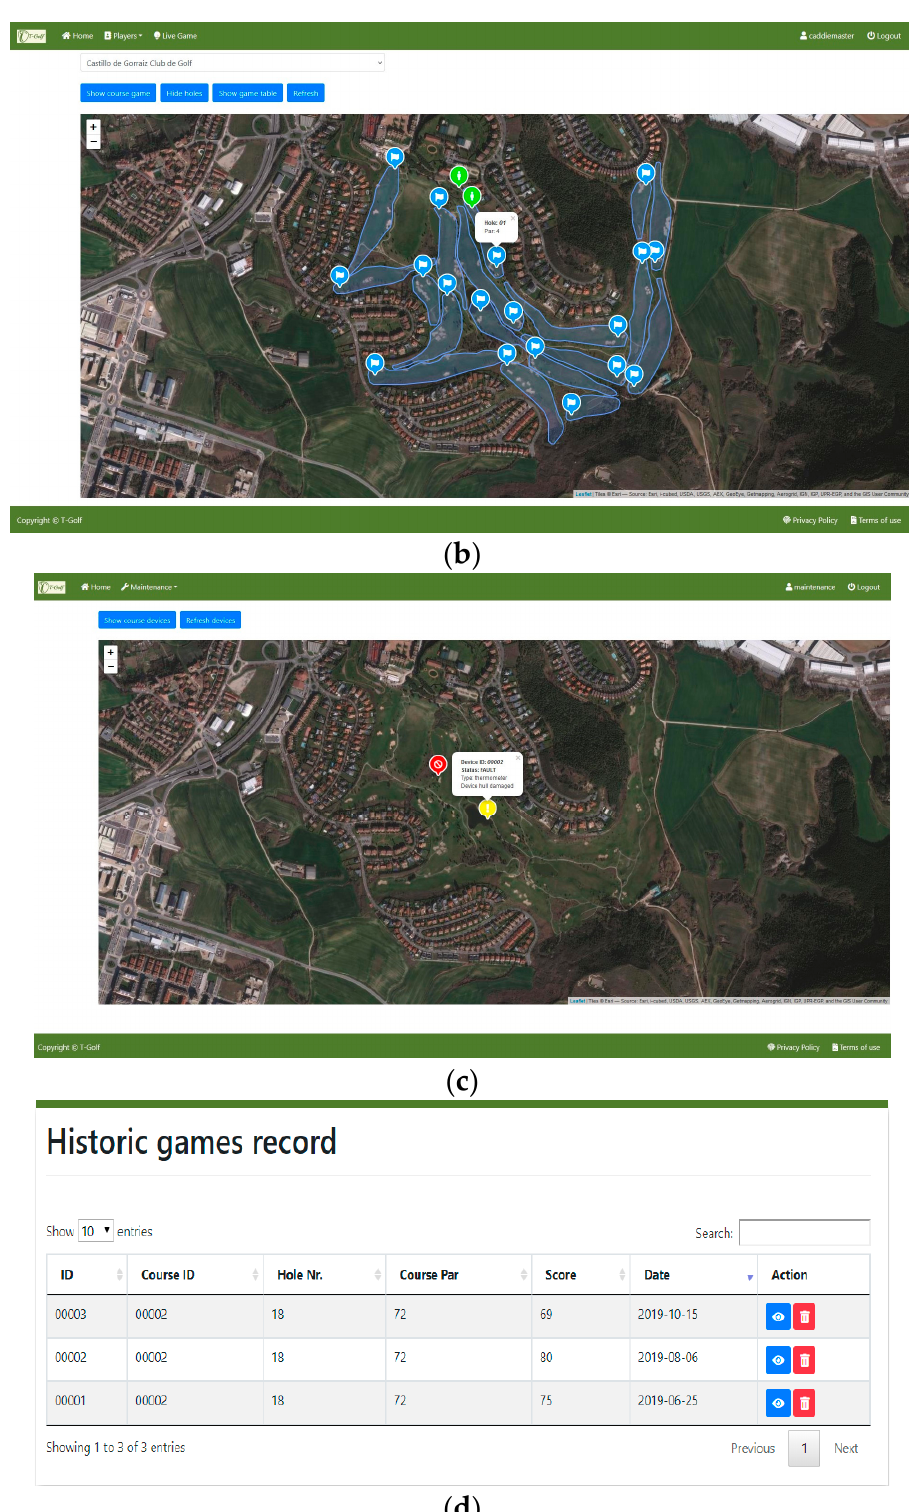
Figure 17. Screenshots of the interface for different user profiles and applications: ( a ) Management screen for the System Administrator profile; ( b ) All players’ location in real time for the Course Administrator user profile; ( c ) State of the golf course screen with warnings for the Maintenance Technician user profile; ( d ) Historic games record for the Player profile.